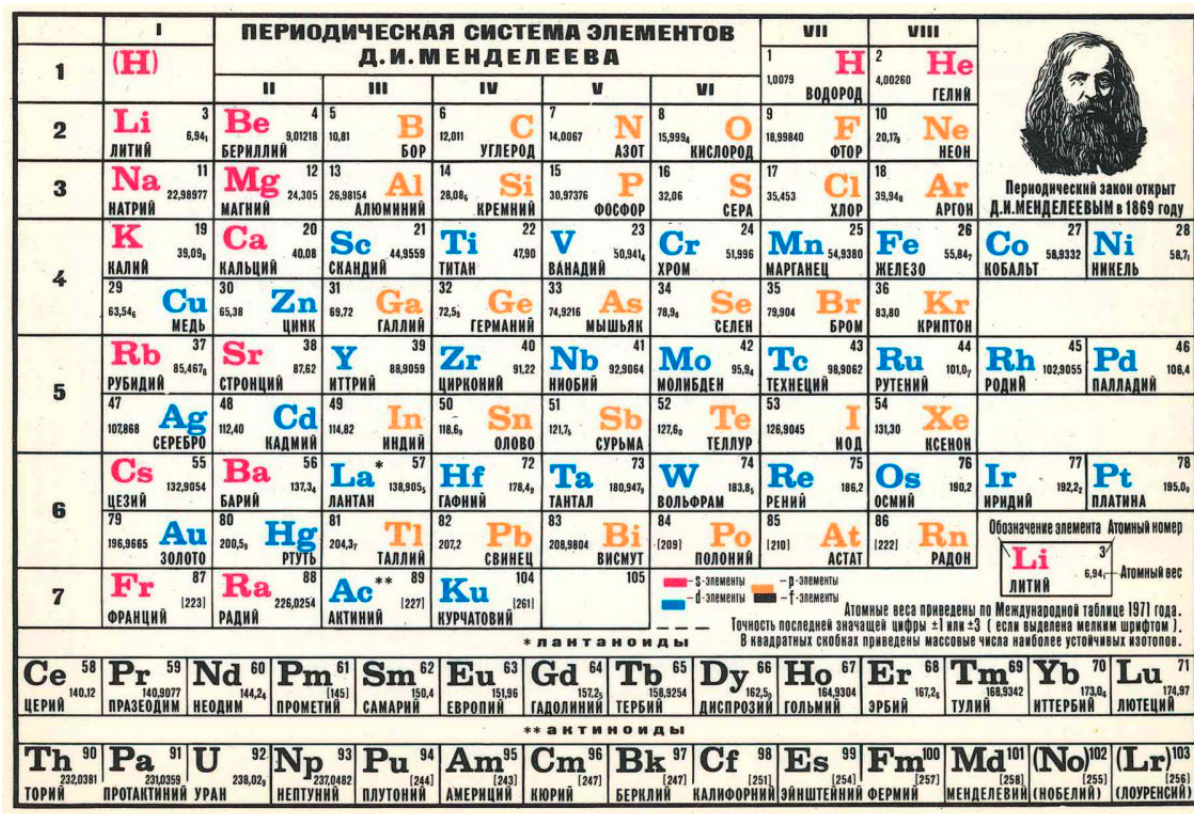
Figure 7. A Russian short-form periodic table that uses colors to denote the elements belonging to different blocks (Khimia, Moscow, 1987) (Photo taken by the author; table in author’s personal